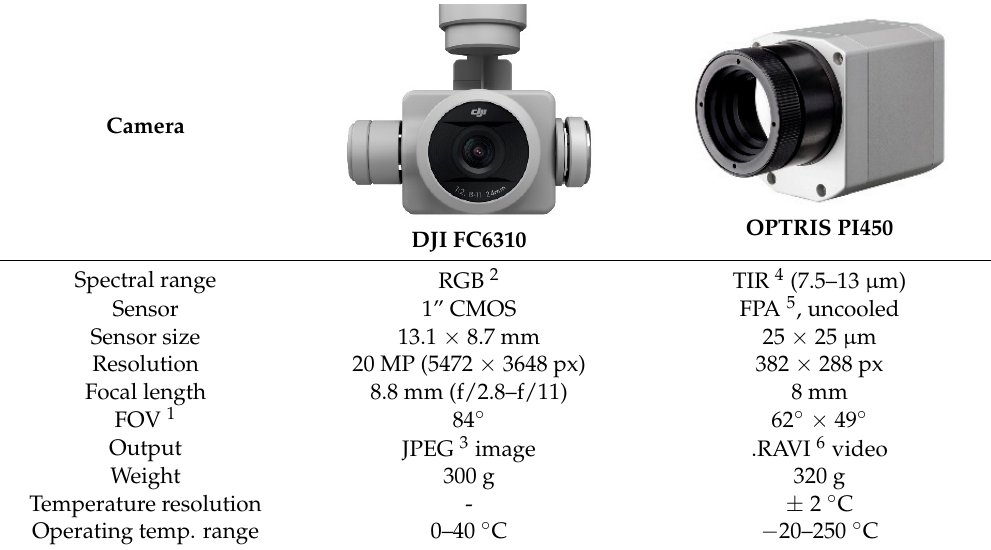
Table 2. Technical specifications of the two sensors: DJI FC6310 (RGB) and OPTRIS PI450 (TIR).